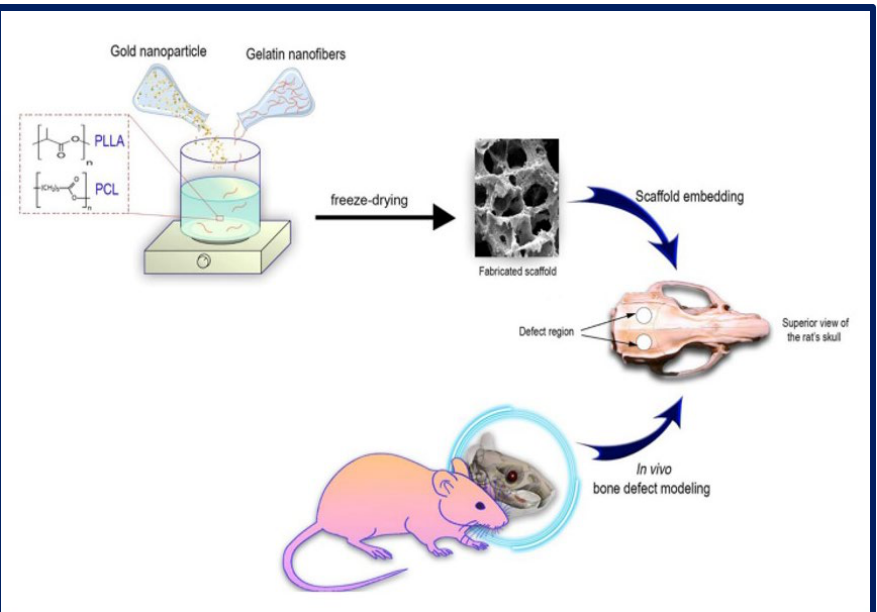
Figure 17. Schematic representation of the in vitro and in vivo experiments using PLLA-PCL-GELATIN scaffolds with gold nanoparticles for bone tissue regeneration. Bibliography consulted [179] is licensed under CC BY 2.0. To view a copy of this license, visit http://creativecommons.org/ licenses/by/4.0/ (accessed on 15 December